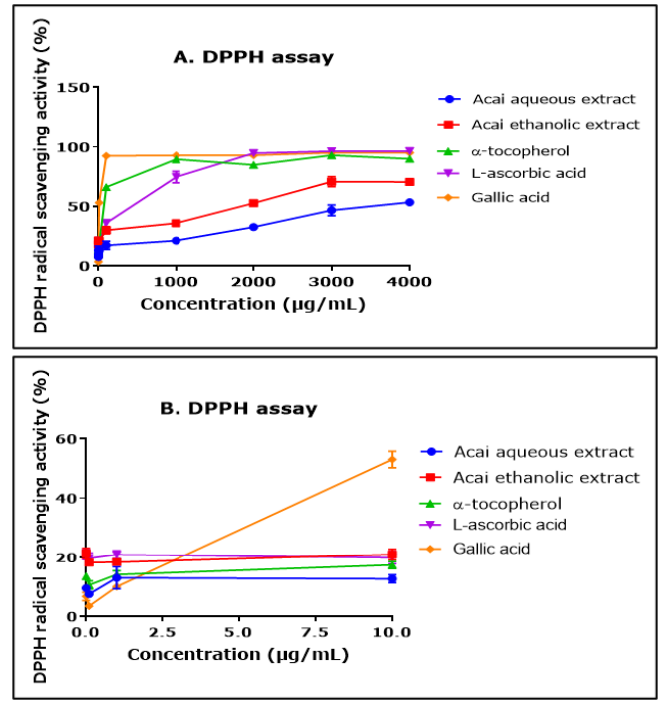
Figure 2. DPPH radical scavenging activity of acai aqueous and ethanolic extracts. Acai antioxi- dant activity was assessed via the percentage inhibition (radical scavenging) of DPPH over a concentration range of 0.01 – 4000 µg/mL ( A ) and 0.01 – 10 µg/mL ( B ). Assays were performed in tripli- cate at each extract concentration ( n = 6).